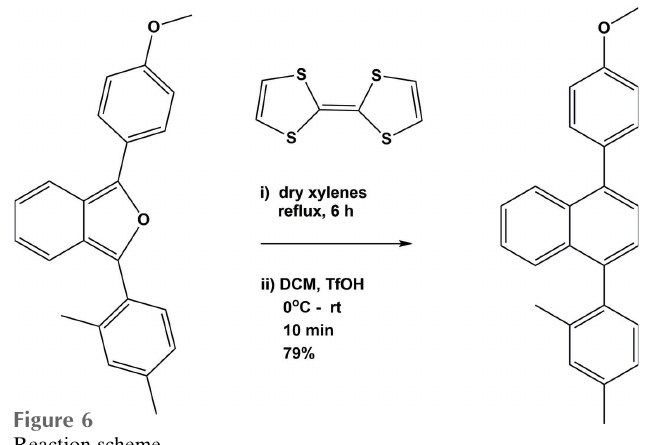
Figure 6 Reaction